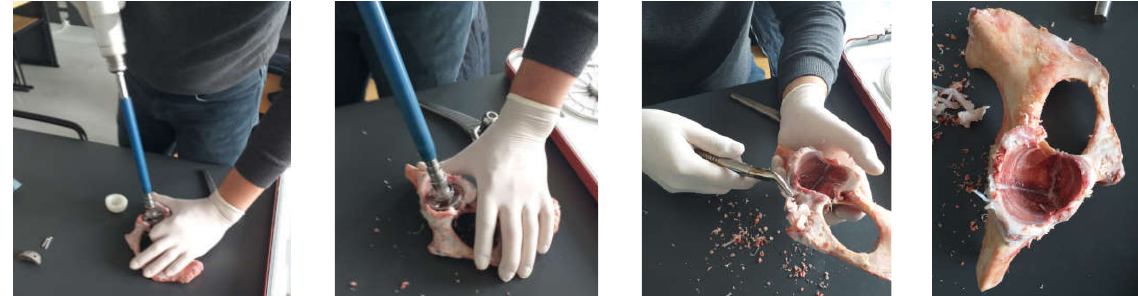
Figure 3. Adaptation of the acetabular cavity to the polyethylene cup (milling, cutting, and removal stages).